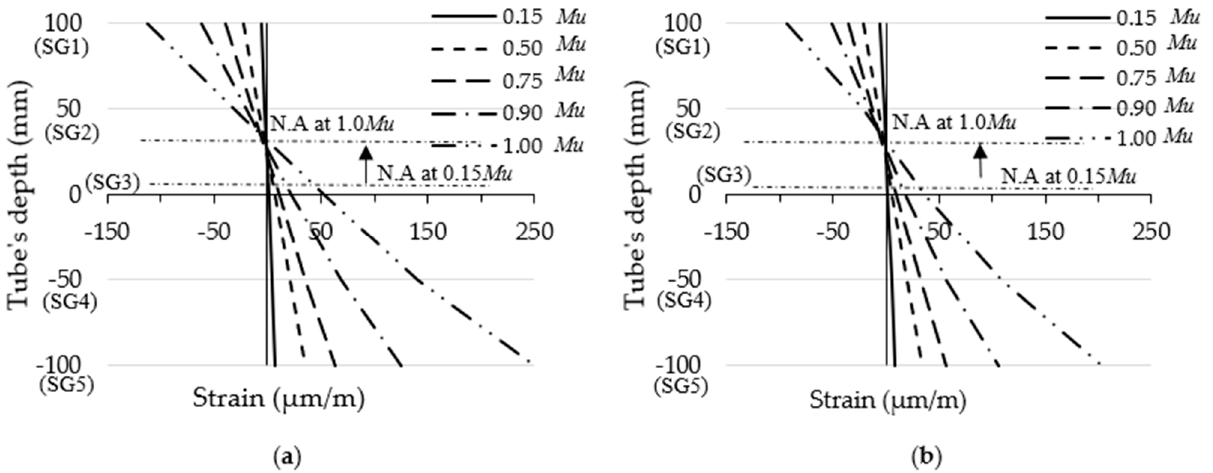
Figure 7. Depth of steel tube cross-section vs. longitudinal strain relationships: ( a ) FB-RC0; ( b ) FB-RC50.